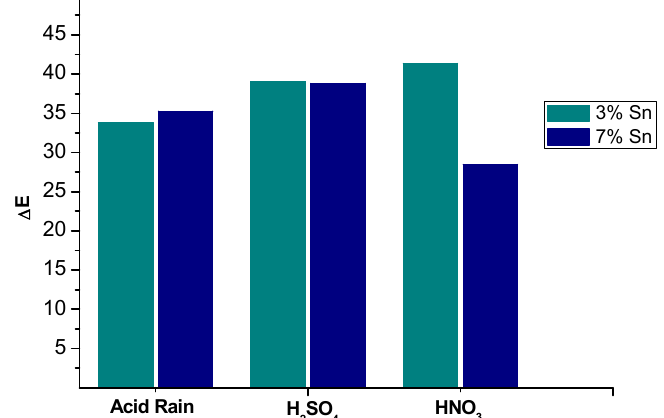
Figure 3. Color difference ( Δ E ) between the clean surfaces of 3% Sn bronze and 7% Sn bronze and after their immersion for five weeks test in synthetic acid rain, sulphuric acid, and nitric acid.